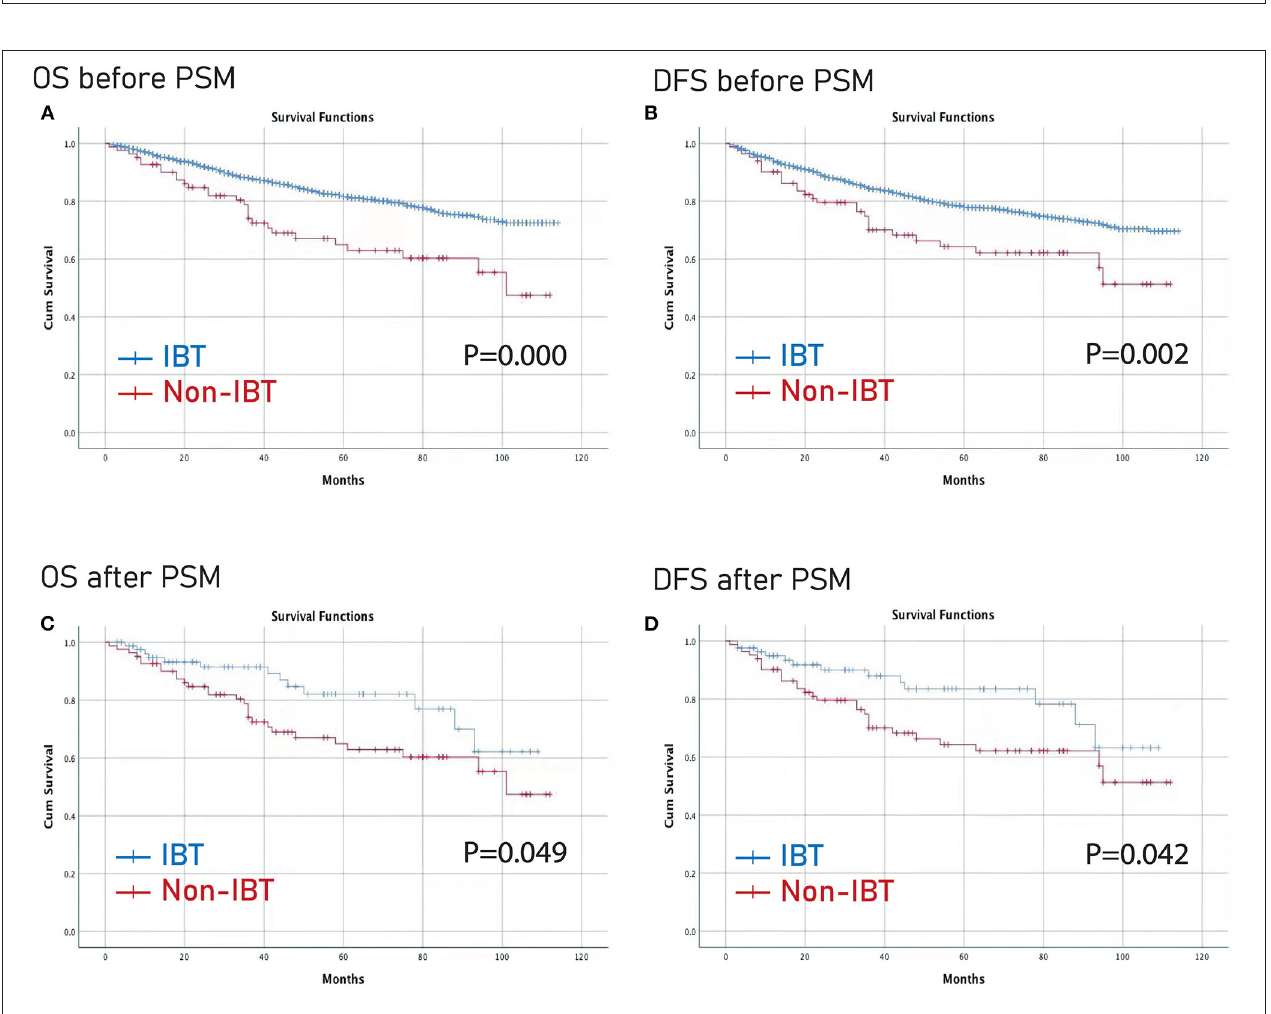
FIGURE 3 | Prognosis of IBT on patients with CRC before and after PSM. (A) OS before PSM; (B) DFS before PSM; (C) OS after PSM; (D) DFS before PSM. OS, overall survival; DFS, disease-free survival; PSM, propensity score matching; IBL, intraoperative blood transfusion; CRC, colorectal cancer.